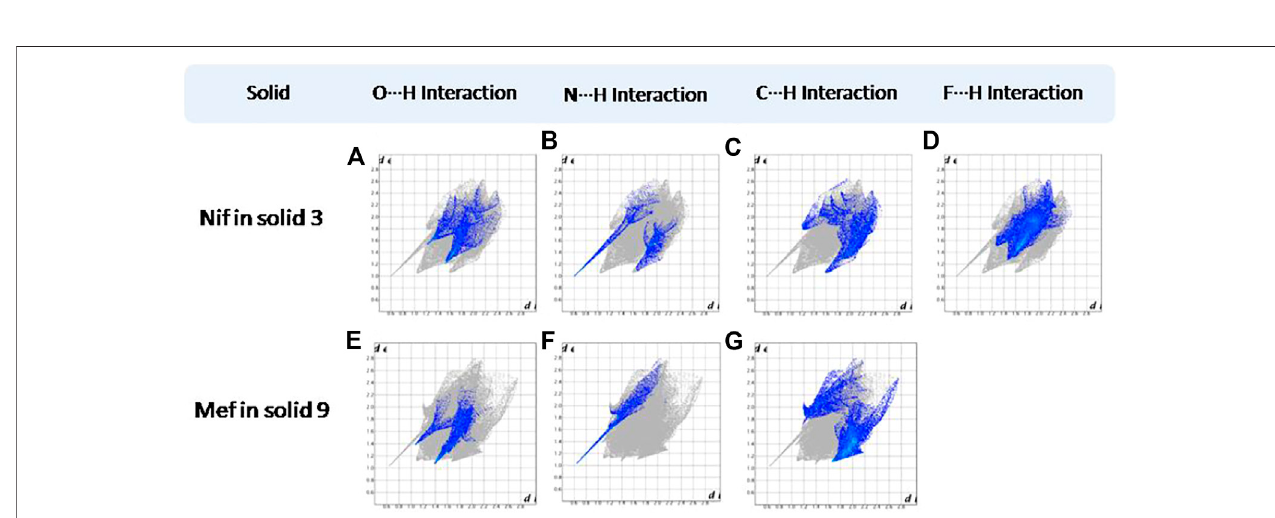
FIGURE 14 | (A – D) Resolved fi ngerprint plots of Nif of solid 3 in O ··· H/ H ··· O, N ··· H/H ··· N, C ··· H/ H ··· C, and F ··· H/ H ··· F interactions, respectively. (E – G) Resolved fi ngerprint plots of Mef of solid 9 in O ··· H/ H ··· O, N ··· H/H ··· N, and C ··· H/H ··· C interactions, respectively.